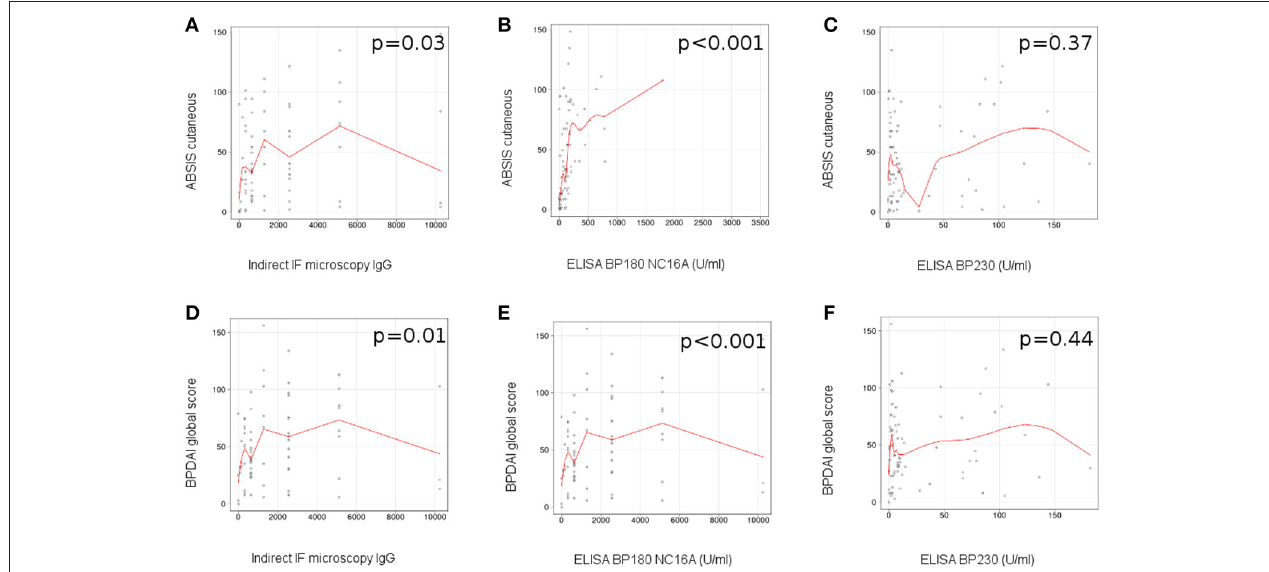
FIGURE 4 | Level of circulating anti-BP180 NC16A, but not anti-BP230 autoantibodies, measured by ELISA correlates with disease activity in patients with bullous pemphigoid. Relation of titers of circulating IgG anti-basement membrane zone autoantibodies, measured by indirect IF microscopy with disease activity: (A), ABSIS score of cutaneous involvement; (D), BPDAI global score ( n = 75). Relation of titers of circulating IgG anti-BP180 NC16A autoantibodies, measured by ELISA with disease activity: (B) , ABSIS score of cutaneous involvement; (E) , BPDAI global score ( n = 75). Relation of titers of circulating IgG anti-BP230 autoantibodies, measured by ELISA with disease activity: (C) , ABSIS score of cutaneous involvement; (F), BPDAI global score ( n = 75). The red line represents the locally weighted scatterplot smoothing